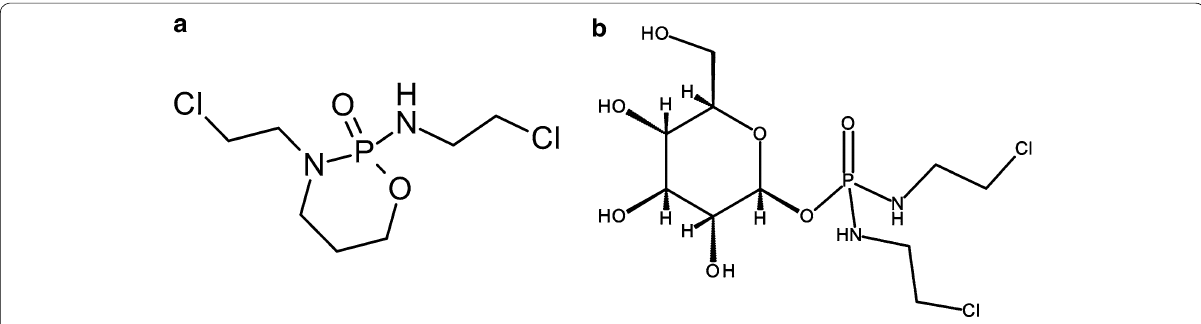
Fig. 3 Structures of the marketed alkylating agent ifosfamide ( a ) and its glucose derivative, glufosfamide ( b